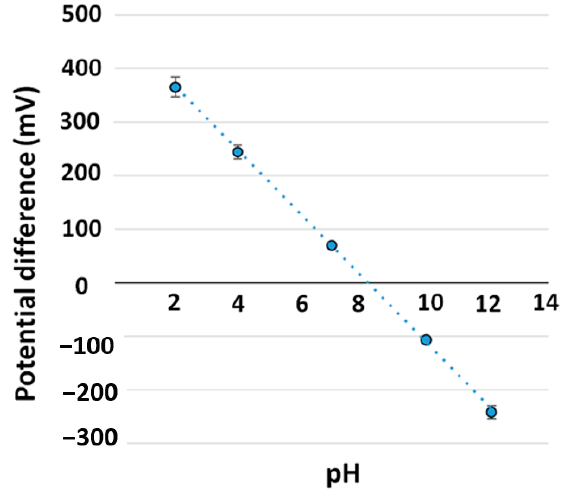
Figure 7. Linear calibration plot for pH sensor from pH 2 to 12, using data from Table 5.